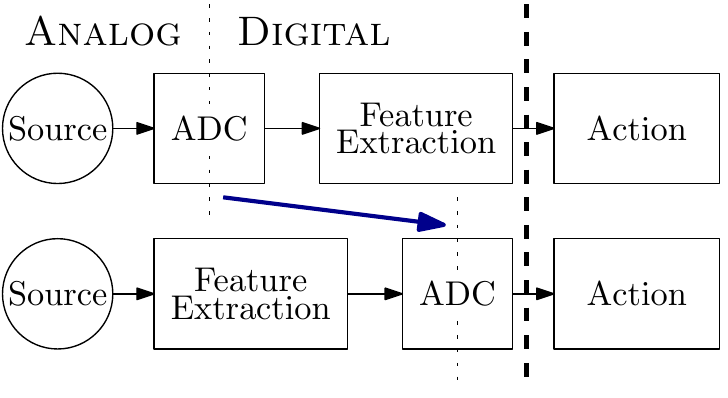
Figure 1. Performing the feature extraction operation in the analog domain moves the system’s analog-to-digital conversion (ADC)